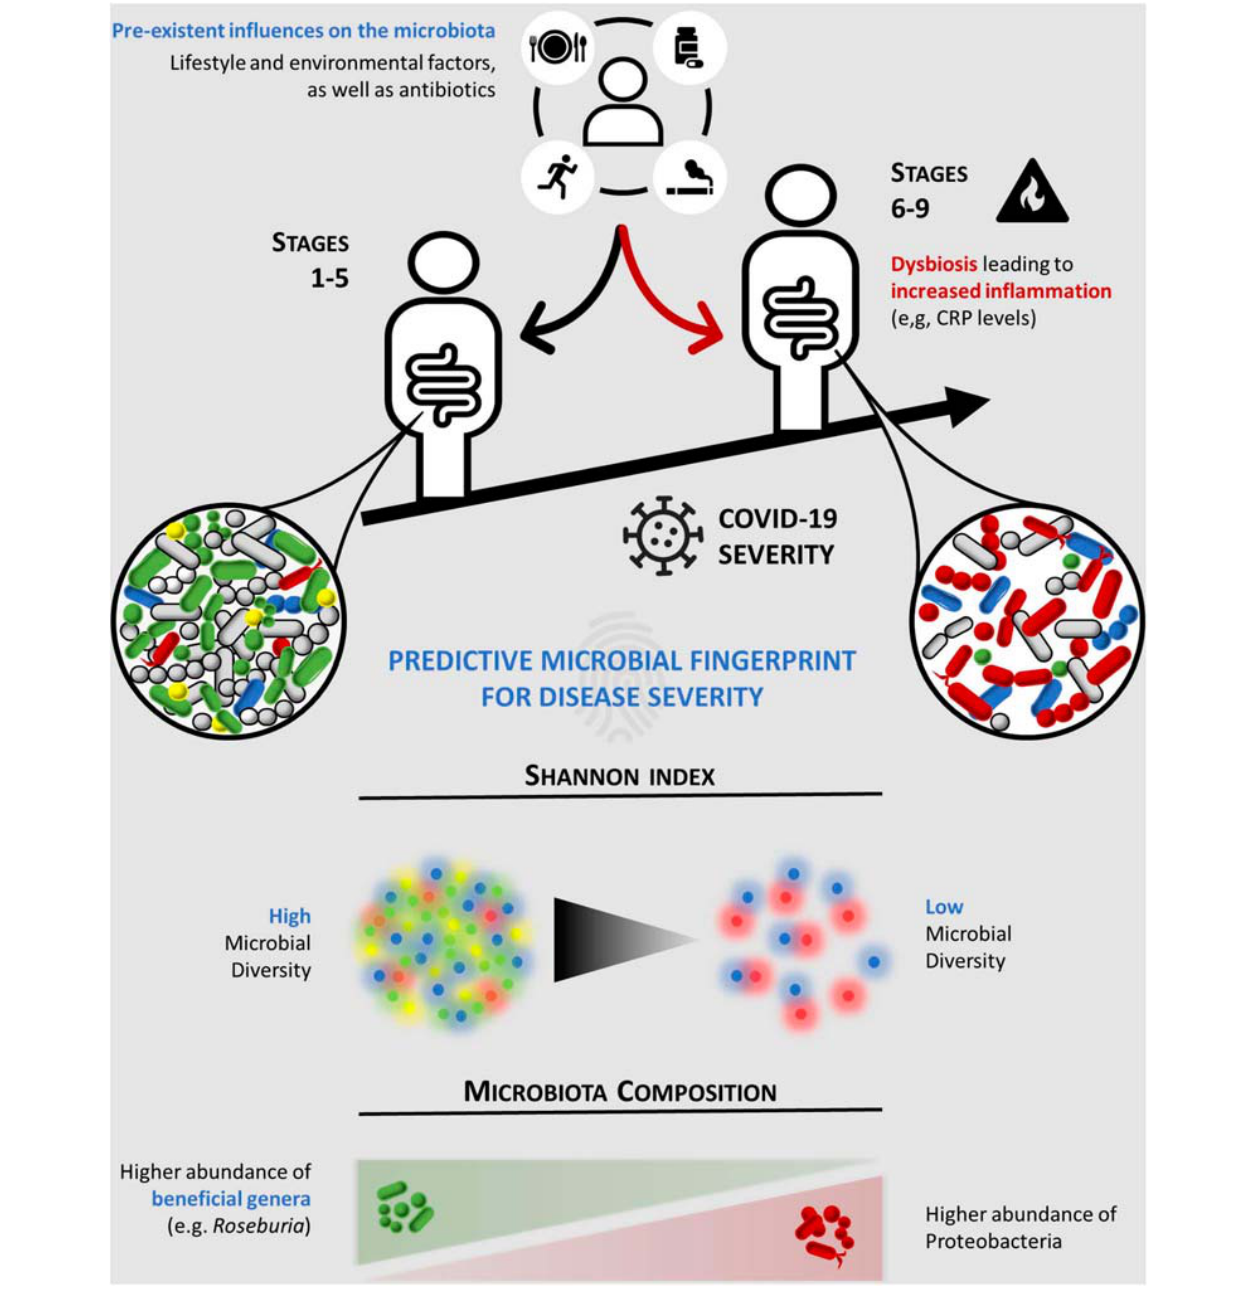
FIGURE 4 | Schematic representation of the predictive microbial fingerprint for coronavirus disease 2019 (COVID-19) severity. Preexistent influences on the microbiota, such as lifestyle and environmental factors, and antibiotics can induce dysbiosis ( red arrow ), leading to increased inflammation (e.g., CRP levels). Hence, lower overall microbial diversity and abundance of beneficial commensal microorganisms (e.g., Roseburia ), along with an increased abundance of Proteobacteria, are associated with high COVID-19 severity (a score of ≥ 6 in the WHO Clinical Progression Scale). CRP, C-reactive protein.